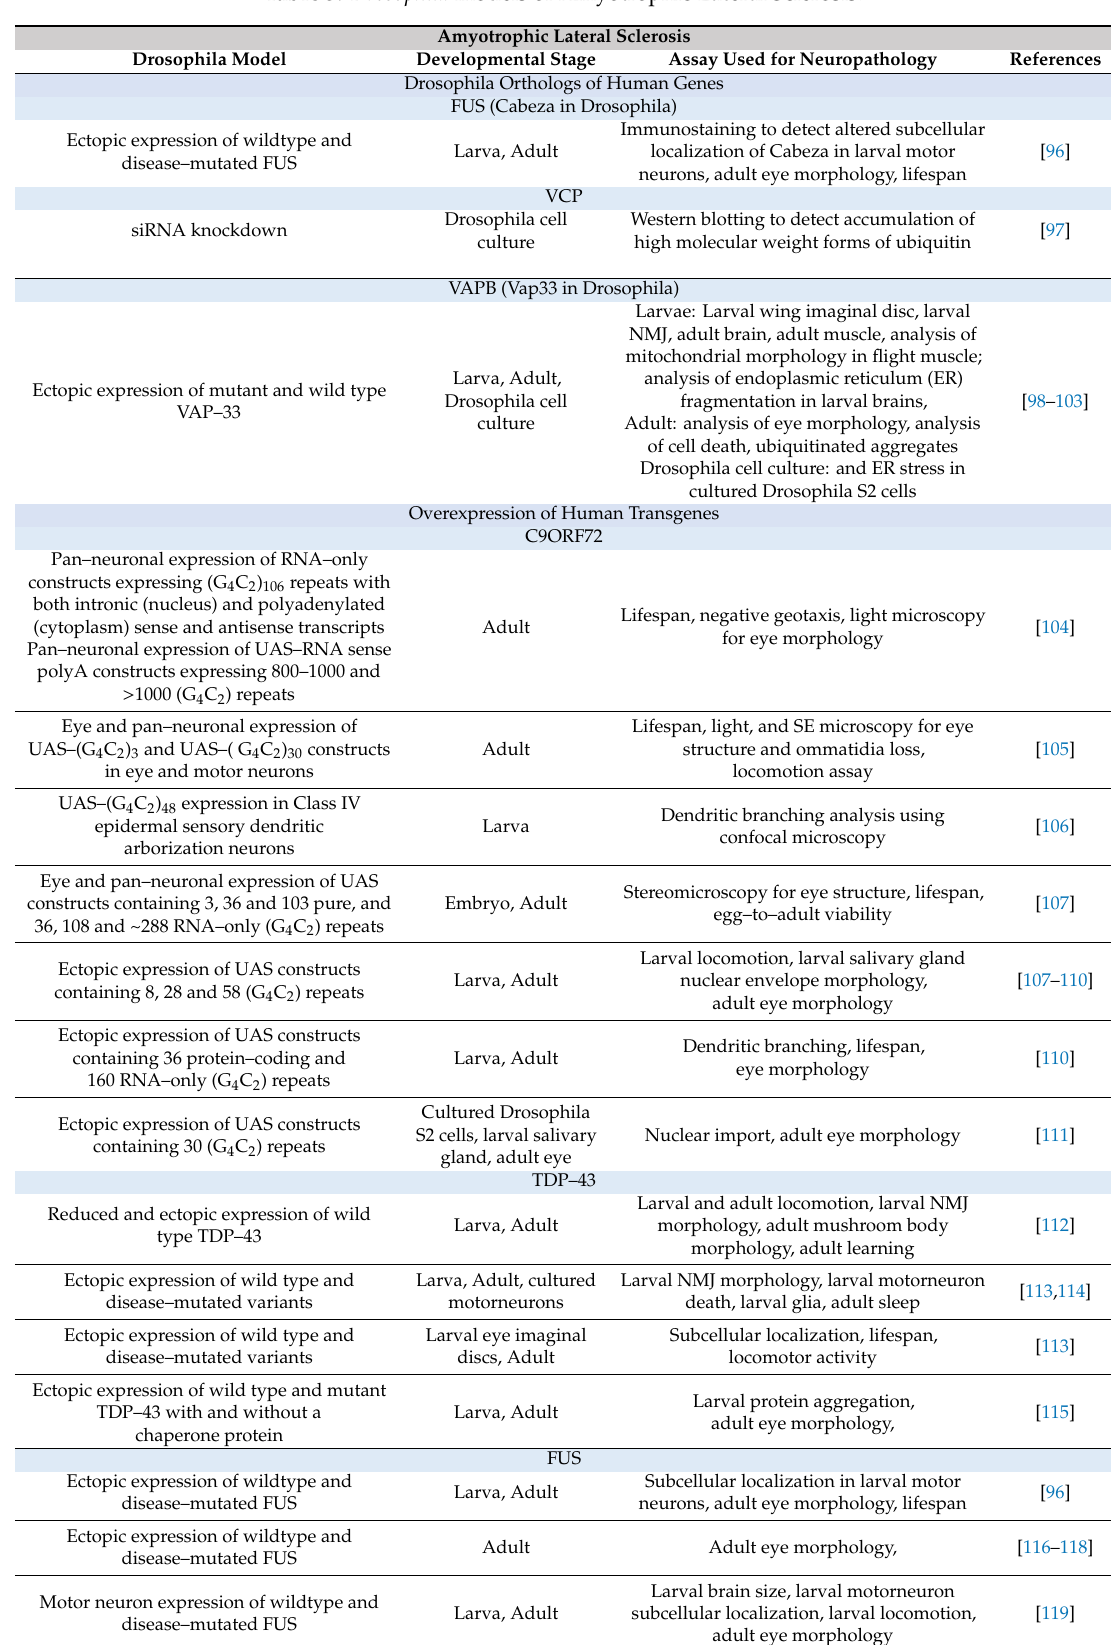
Table 3. Drosophila models of Amyotrophic Lateral